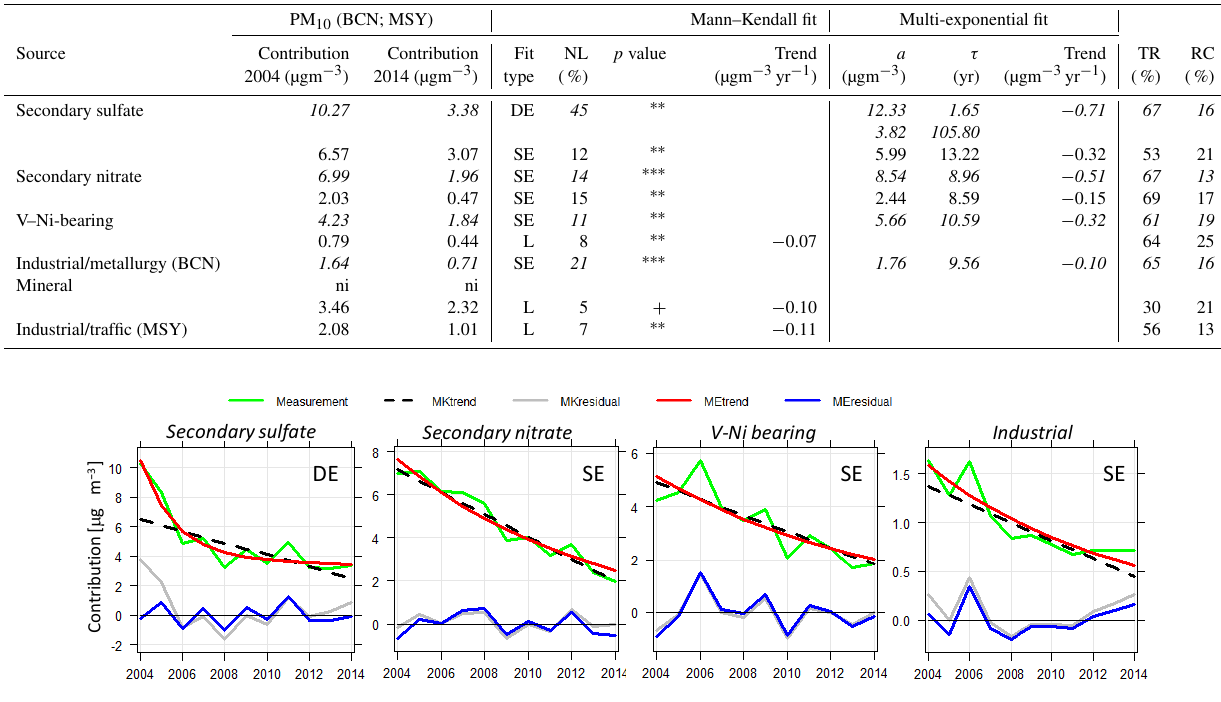
Figure 6. Mann–Kendall and multi-exponential trends for source contributions in PM 10 at BCN. Measured concentration (green line); multi-exponential trend (red line); multi-exponential residuals (blue line); Mann–Kendall trend (black line); Mann–Kendall residuals (gray line). Trend type: linear (L), single exponential (SE), double exponential (DE). The source contributions at BCN from mineral, traffic, and road/work resuspension were excluded from the trend